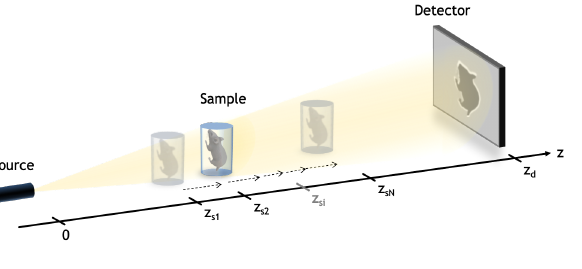
Figure 3. Holography imaging set-up. A coherent beam traverses the sample and propagates a certain distance before reaching the detector. Interference fringes due to wave perturbation in the sample appear on the detector plane and vary according to the distance of propagation. Several images with various distances of propagation or only one position can be taken.